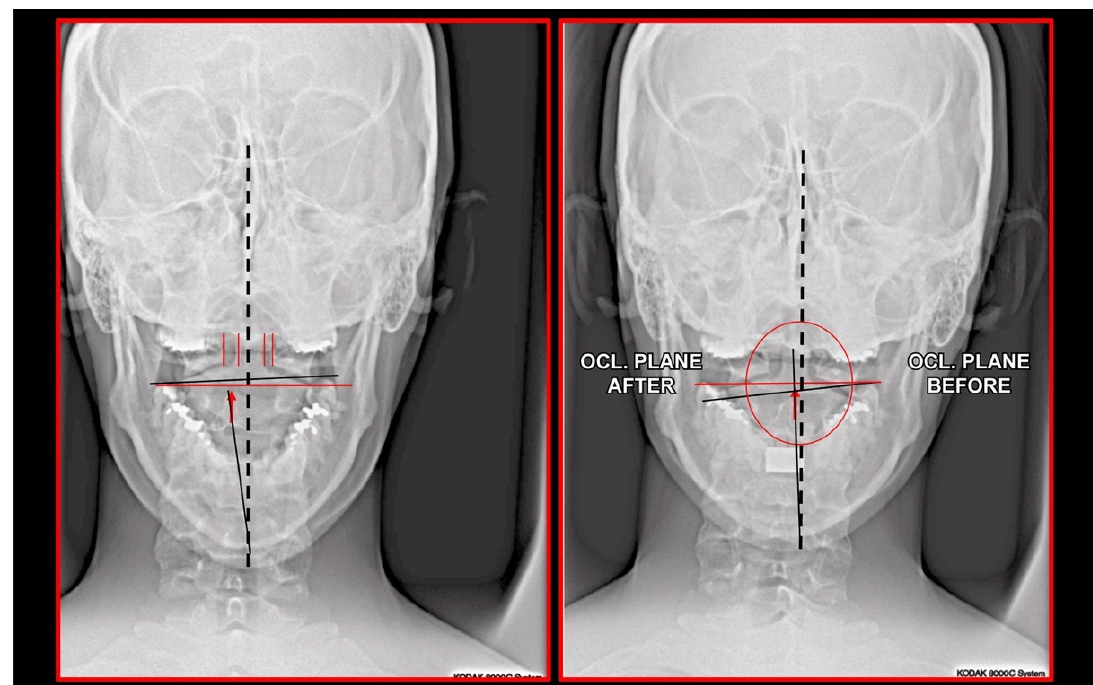
Figure 24. Radiographic situation before and after one session of orthopedic manual therapy.